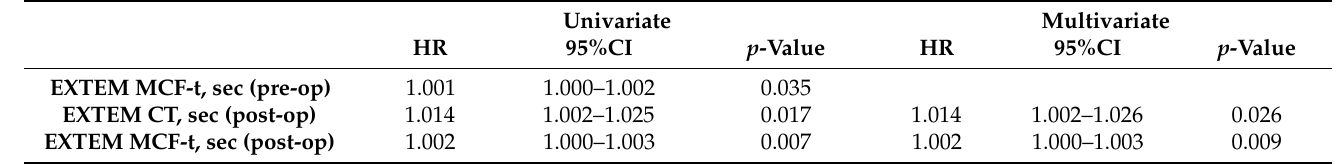
Table 4. Univariate and multivariate analyses of predictors for EAD after LDLT.